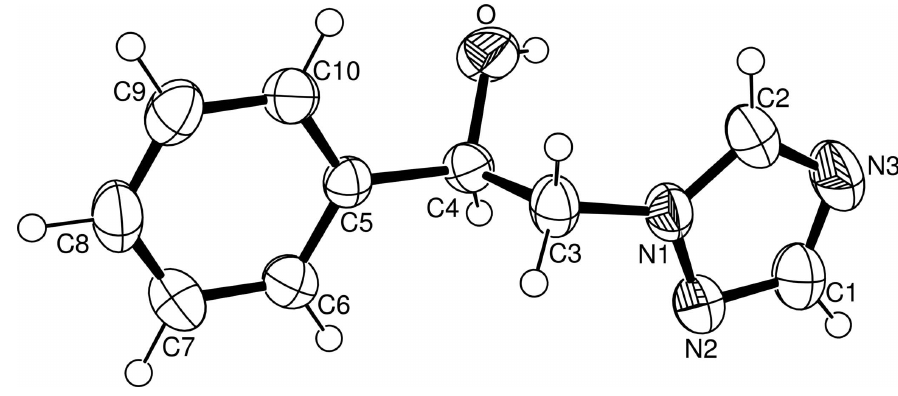
Figure 1 The molecular structure of the title molecule with the atom-numbering scheme. Displacement ellipsoids are drawn at the 50% probability level.